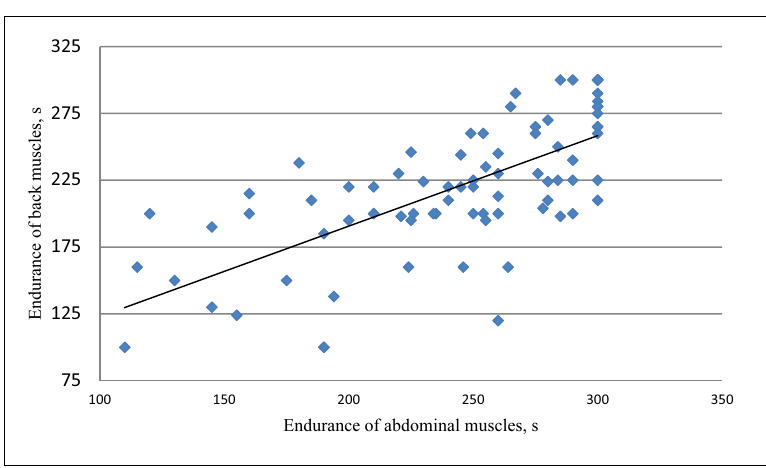
Note. r = 0.72; p < 0.001. Figure 4. Correlations between the strength of transversus abdominis muscle and endurance of abdominal muscles for the study subjects